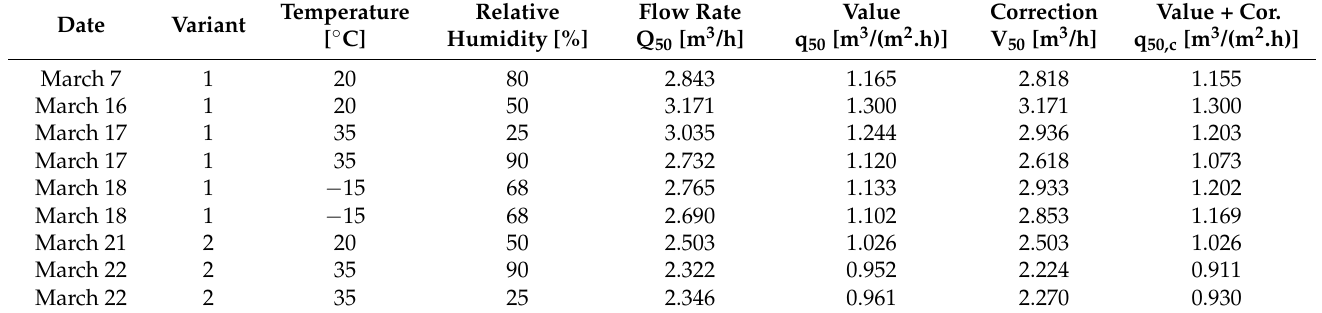
Figure 16. Linear regression graph for airtightness measurements of the 2nd variant, Q 50 = 2.503 m 3 /h, q 50 = 1.026 m 3 /(m 2 .h). Table 3. Results of the airtightness measurements.